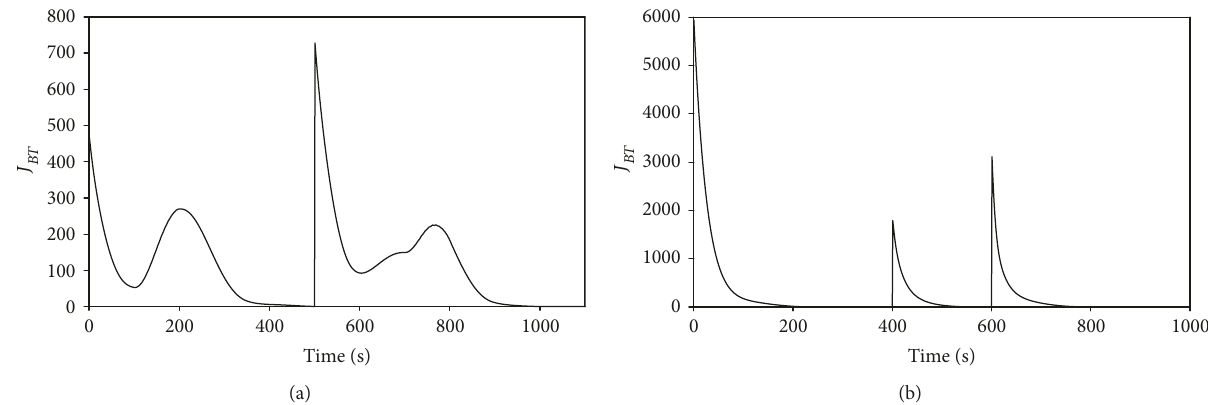
Figure 11: Performance indexes in the case of (a) wide-range load tracking and (b) existing constant output